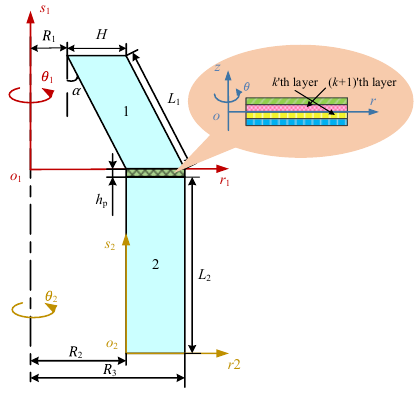
Figure 1. Cross-section geometrical parameters and coordinate system of the coupled